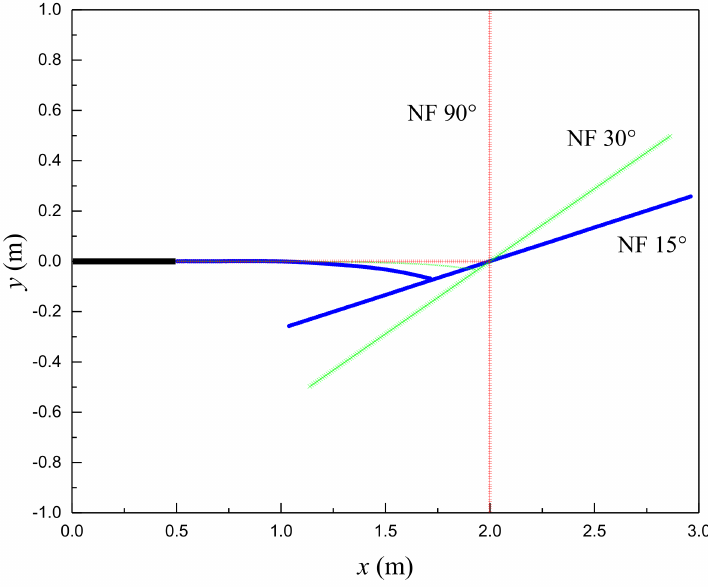
Figure 16. HF propagation path at different NF inclination